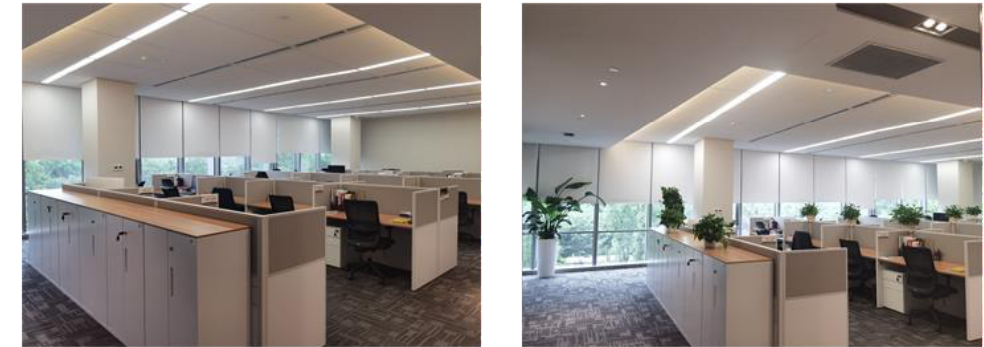
Figure 1. Example of plants placement in field experiment (Study 2).